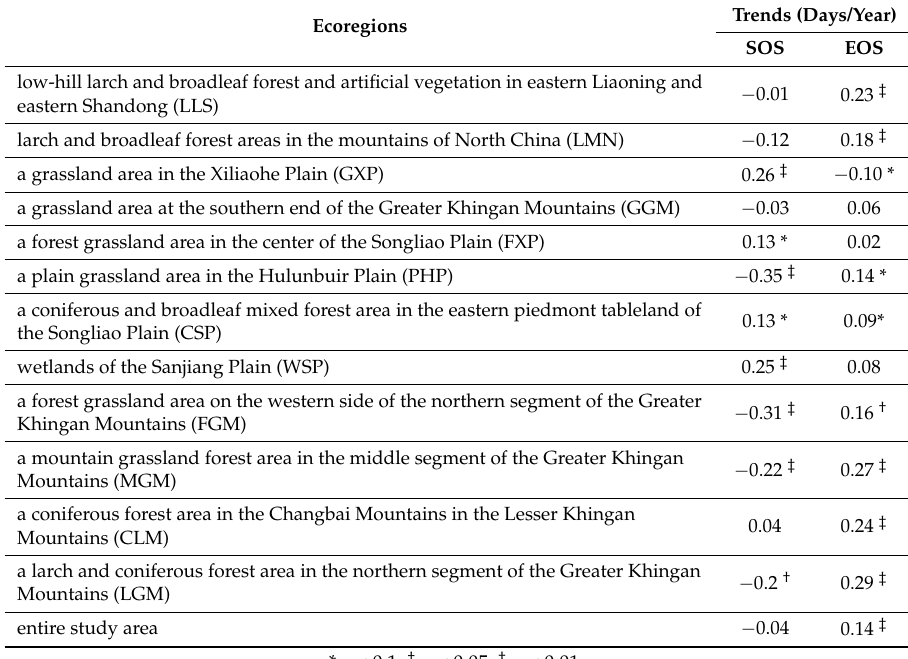
a plain grassland area in the Hulunbuir Plain (PHP) a coniferous and broadleaf mixed forest area in the eastern piedmont tableland of the Songliao Plain